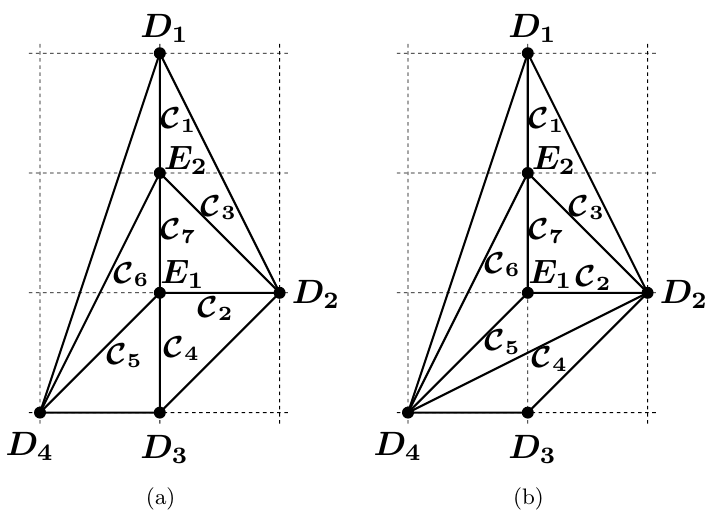
Figure 4 . The two crepant resolutions of the E 12 ; 2 singularity. Resolution (a) admits a vertical